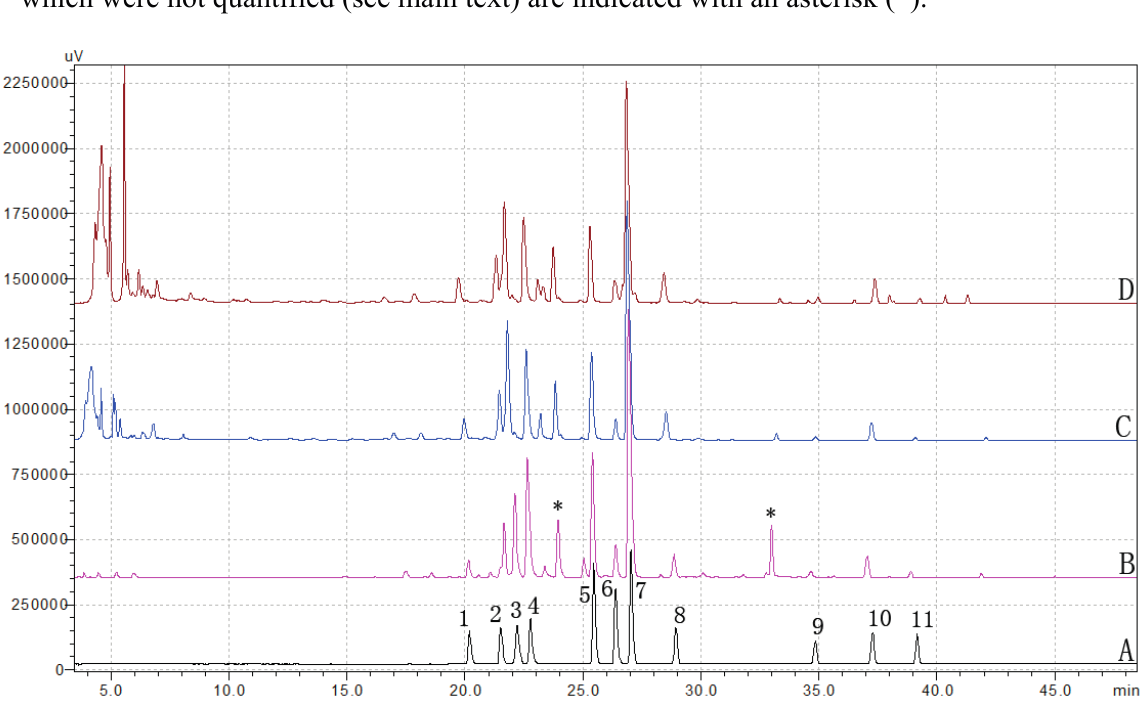
Figure 2. Representative HPLC chromatograms of Corydalis Rhizoma samples and reference compounds. Mixture of reference compounds ( A) ; methanol extract of Corydalis Rhizoma ( B ); water decoction of Corydalis Rhizoma ( C ); water decoction of JLZS ( D ). Protopine ( 1 ), α -allocryptopine ( 2 ), tetrahydrocolumbamine ( 3 ), coptisine ( 4 ), palmatine ( 5 ), berberine ( 6 ), dehydrocorydaline ( 7 ), DL-tetrahydropalmatine ( 8 ), tetrahydroberberine ( 9 ), corydaline ( 10 ), tetrahydrocoptisine( 11 ); two additional abundant compounds of B which were not quantified (see main text) are indicated with an asterisk